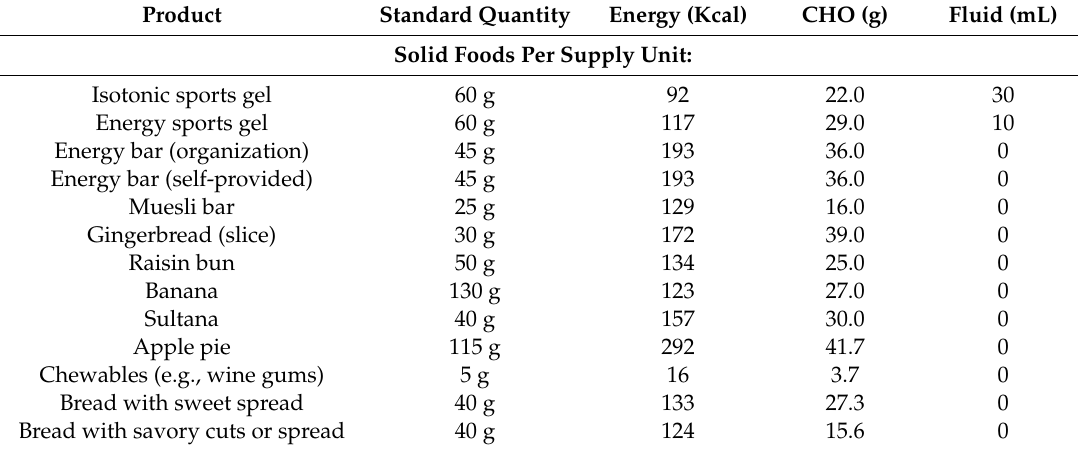
Table 1. Quantity, energy, carbohydrate, and fluid content of pre-specified foods and beverages listed in the